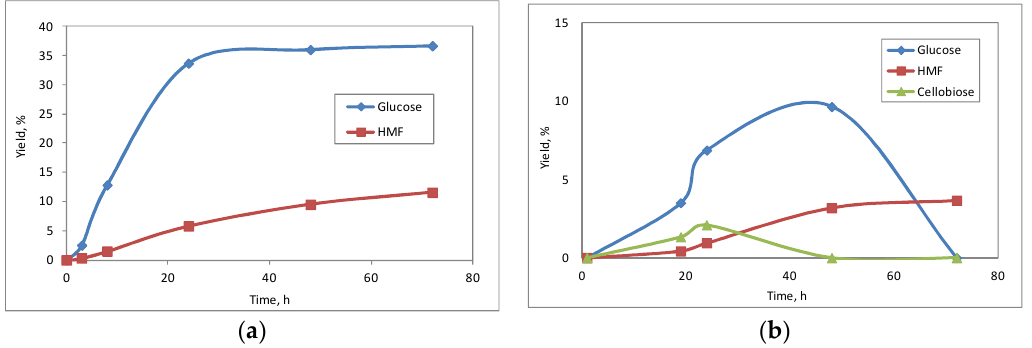
Figure 5. Efficiency of cellulose degradation in [BMIM]Cl at 100 °C by using phosphotungstic acid hydrate added ( a ) 20 min before the substrate, ( b ) 3 h after the substrate. Catalyst loading was 10 wt % from cellulose and cellulose loading was 10 wt % from solvent.